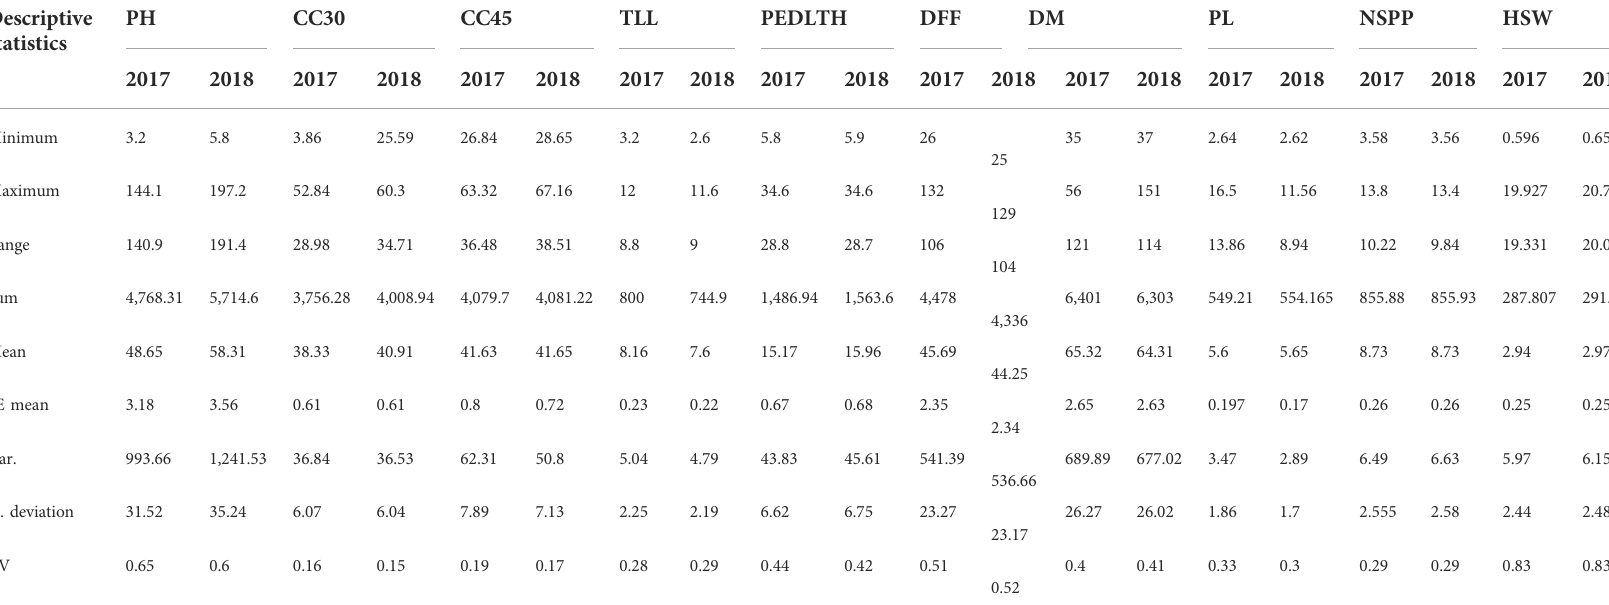
TABLE 1 Descriptive statistics of quantitative